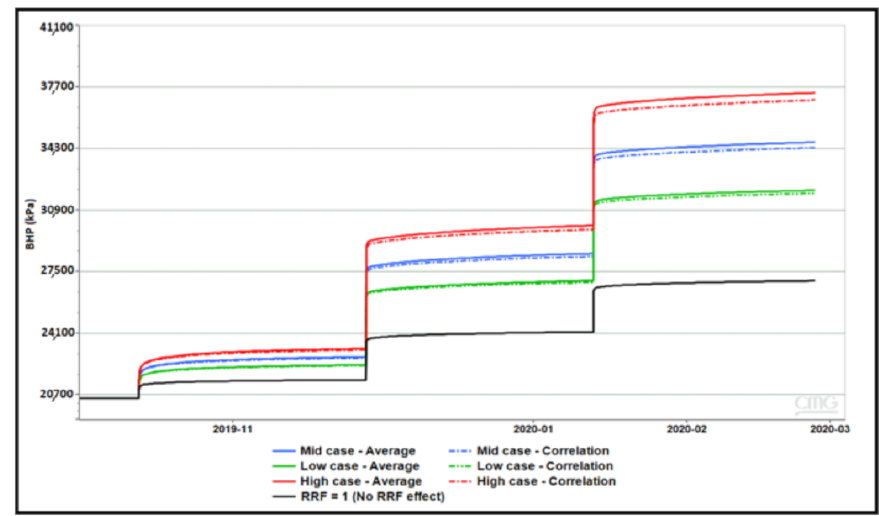
Figure 14. Impact of RRF correlation and averages on rate stepping.